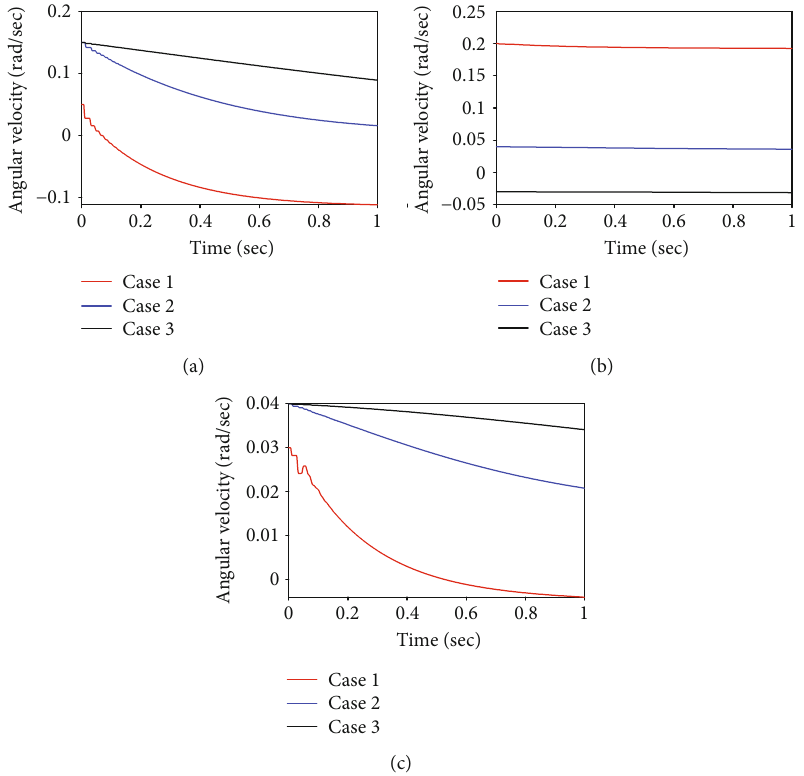
Figure 19: Angular velocity of the target satellite during identi fi cation: (a) X axis, (b) Y axis, and (c) Z